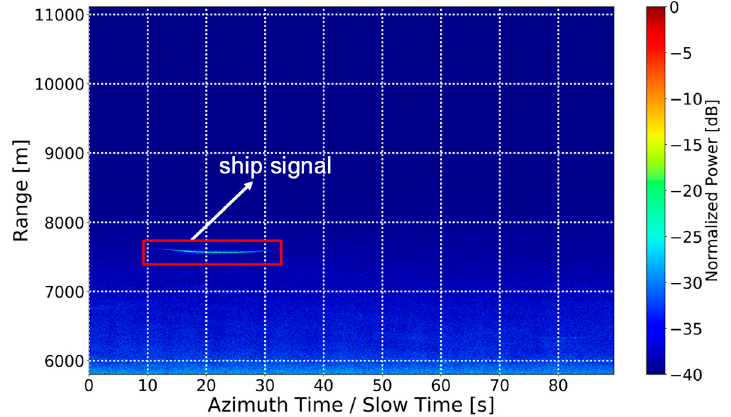
Figure 10. RC F-SAR X-band HH polarized radar data acquired during a linear flight track. Ship signal is indicated in the figure.